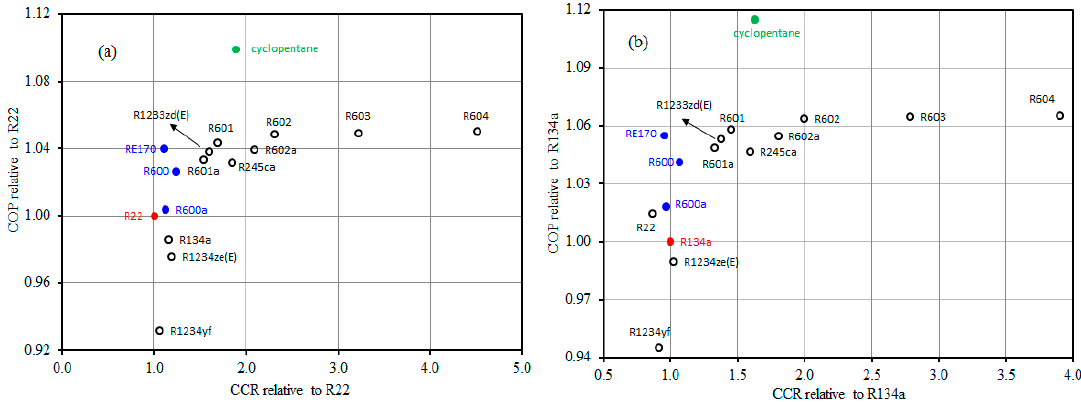
Figure 5. Comparison of the COP and CCR of pure alternative refrigerants relative to R22 ( a ) and R134a ( b ).